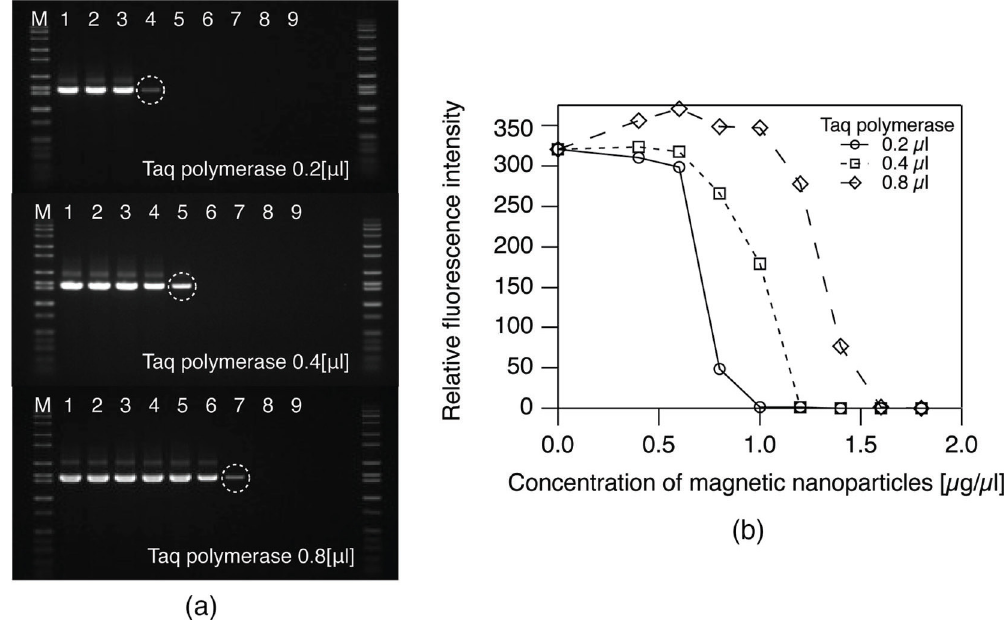
Figure 3. Amplified DNA bands with EMG607 magnetic nanoparticles having different amounts of Taq polymerase observed using agarose gel electrophoresis. Lane 1: control without magnetic nanoparticles; lanes 2–9: 0.4, 0.6, 0.8, 1.0, 1.2, 1.4, 1.6 and 1.8 μ g/ μ L of EMG607 magnetic nanoparticles, respectively. ( a ) The amounts of Taq polymerase used were 0.2–0.8 μ g/ μ L; ( b ) Dependence of PCR product yield with EMG607